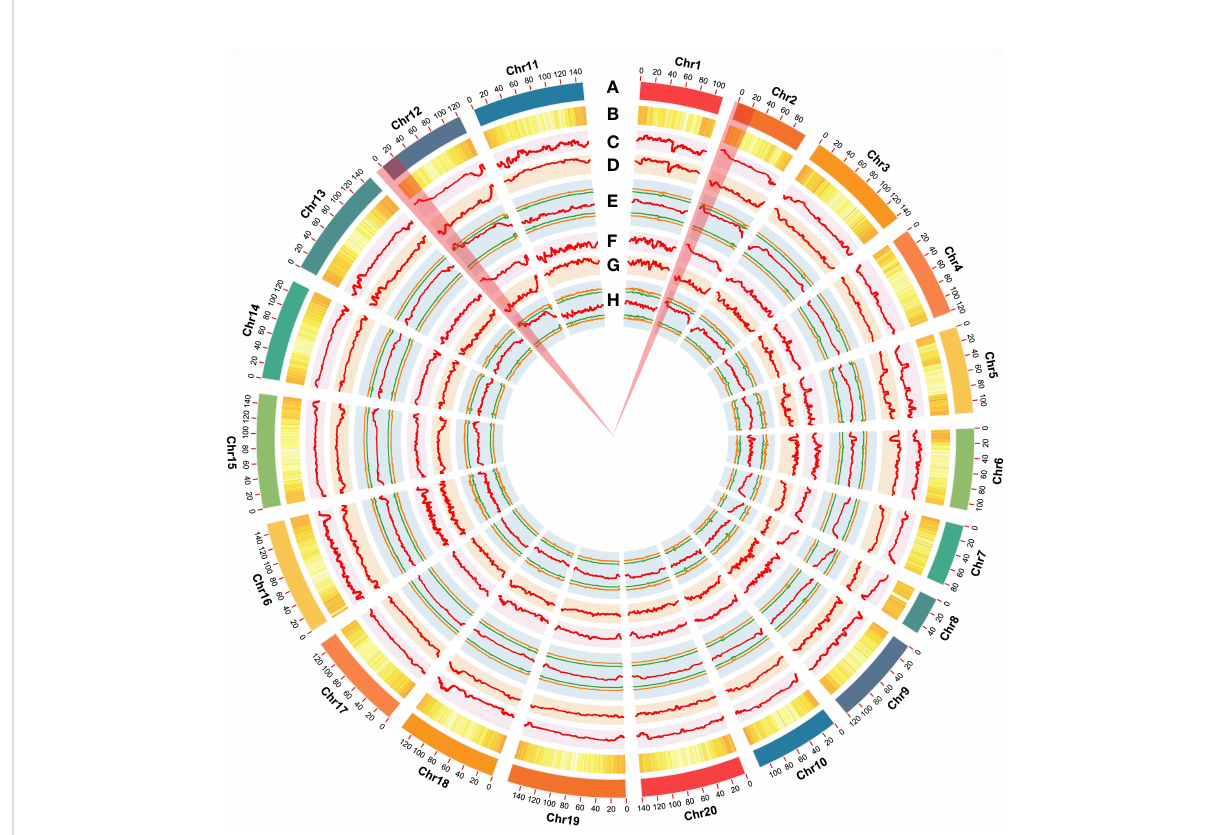
FIGURE 3 Genome-wide summary of the putative genomic regions associated with resistance to Ralstonia solanacearum infections. (A) Chromosomes of the cultivated peanut reference genome. (B) The genome-wide density of total genes. (C, D) Plots of SNP-index of R- and S-bulks generated by sliding-window analyses of cultivated peanut chromosomes. (E) D SNP-index plot generated by using the Shitouqi assembly as a reference genome. Label de fi nitions from outside to inside: upper probability values at 99% (orange) and 95% (green) con fi dence levels. D SNP-index, lower probability values at 95% (green), and 99% (orange) con fi dence levels. (F, G) InDel-index of R- and S-bulks plots generated by sliding- window analyses of cultivated peanut chromosomes. (H) D InDel-index plot generated by using the Shitouqi assembly as a reference genome. Label de fi nitions from outside to inside: upper probability values at 99% (orange) and 95% (green) con fi dence levels. D SNP-index, lower probability values at 95% (green) and 99% (orange) con fi dence